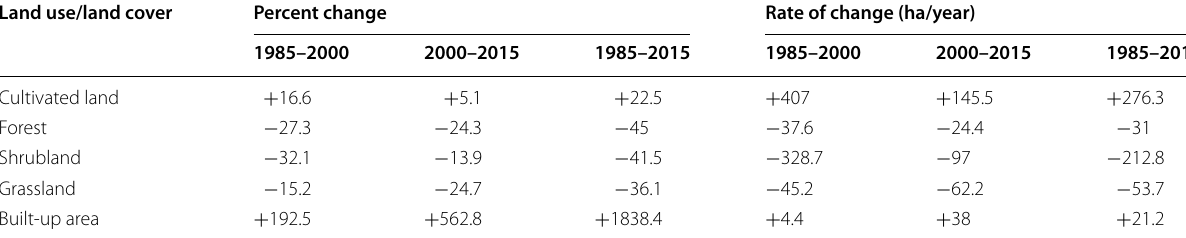
Table 6 Percent and rate of changes occurred in the Andassa watershed from 1985 to 2015 periods Land use/land cover